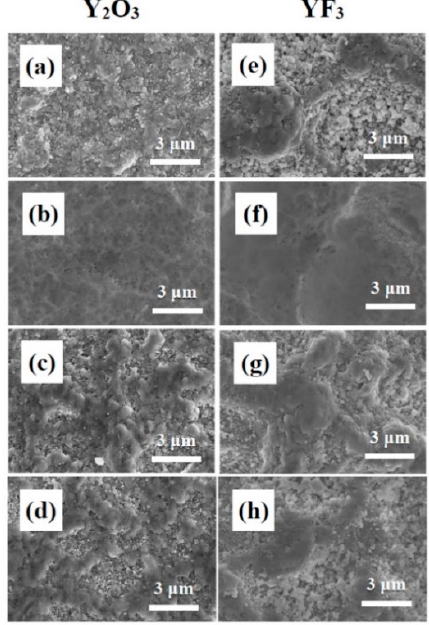
Figure 3. FE-SEM images of the surface of Y 2 O 3 and YF 3 coatings before and after exposure to NF 3 plasma: ( a ) Y 2 O 3 and ( e ) YF 3 before etching; ( b ) Y 2 O 3 and ( f ) YF 3 after etching of the powered electrode; ( c ) Y 2 O 3 and ( g ) YF 3 after etching of the grounded electrode; ( d ) Y 2 O 3 and ( h ) YF 3 after etching of the